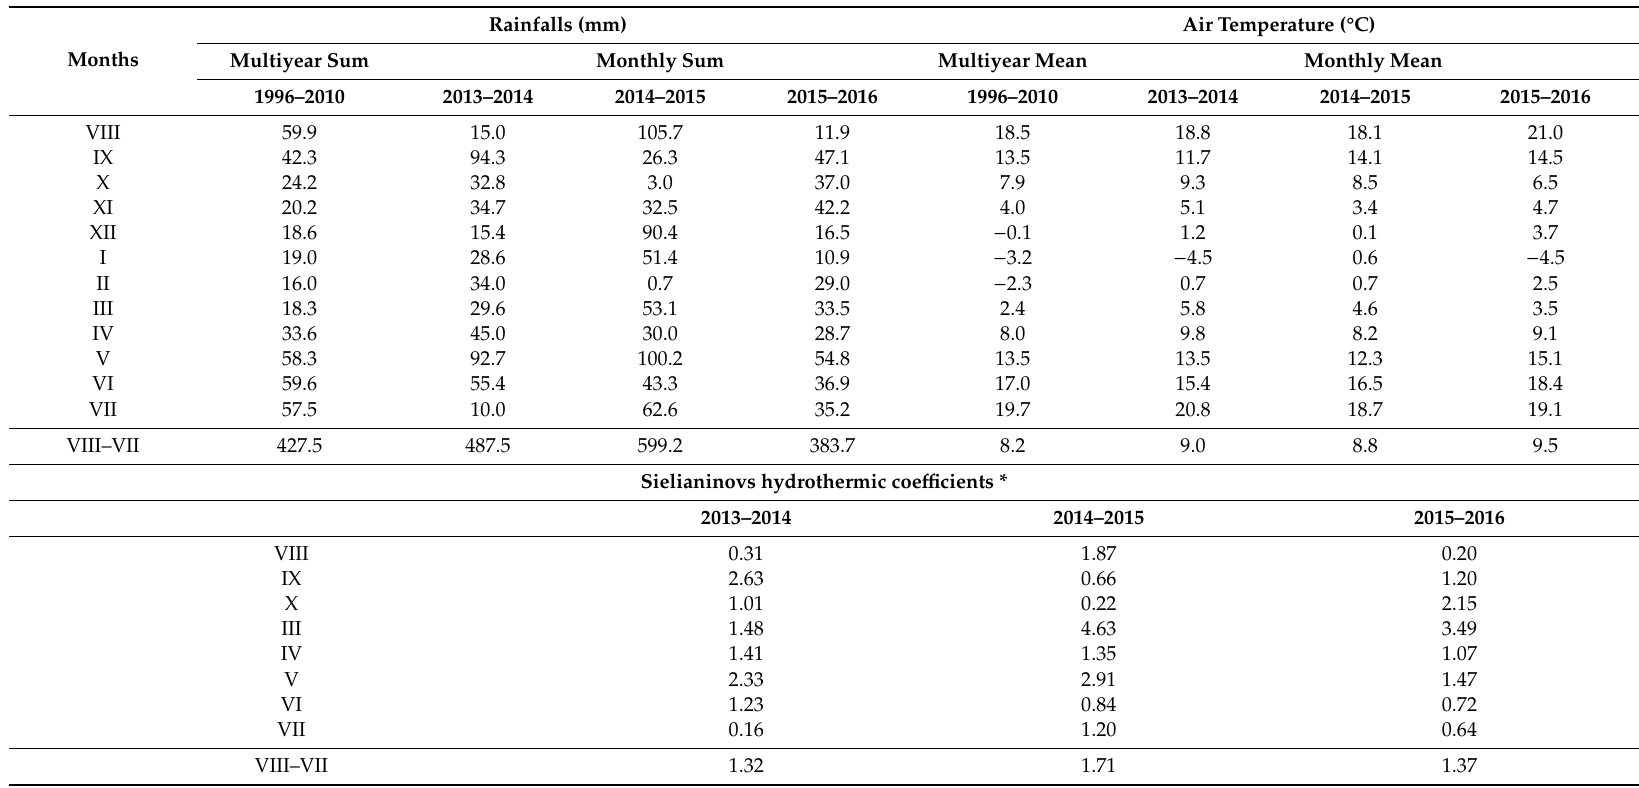
Table 1. Characteristics of weather conditions in the years 2013–2016